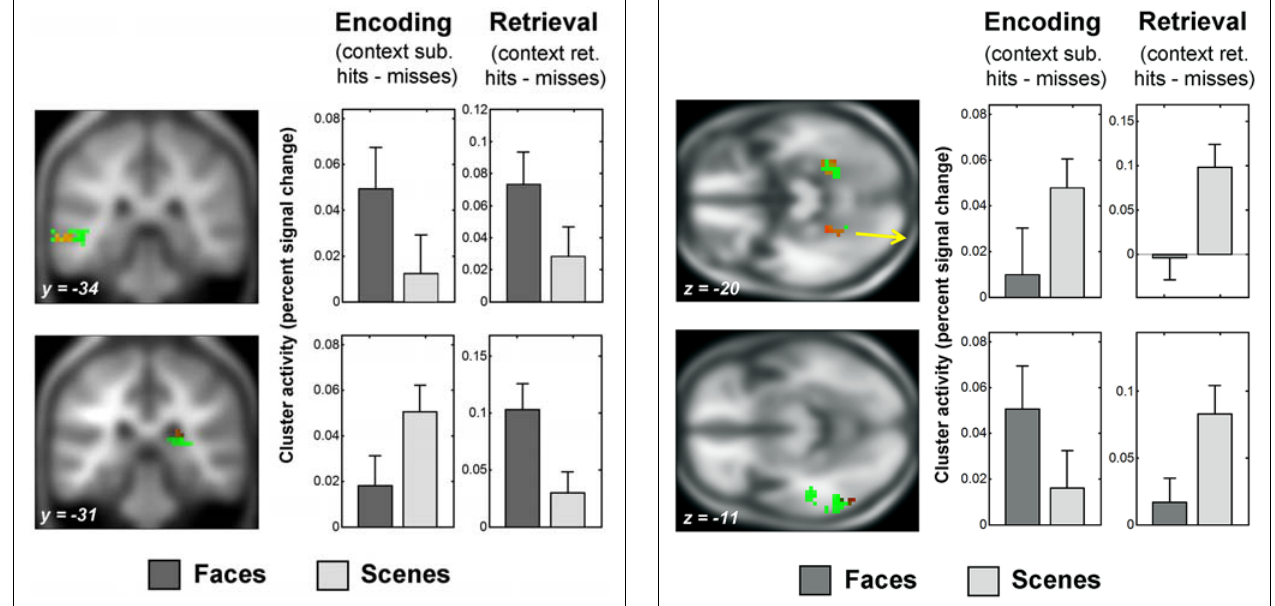
FIGURE 4 | Recapitulation of encoding activity during scene context retrieval. The sections show the overlap of selective context retrieval effects (overlap shown in red) with selective context encoding effects (shown in green), displayed on the average anatomicalT1 image from this sample.Thresholds for display are those used in the overlap analysis (see Behavioral Analysis). Above: posterior parahippocampal gyrus regions which showed scene-selective encoding activity and scene-selective retrieval activity (peak x = − 24, y = − 40, z = − 20; and x = 30, y = − 46, z = − 17). Below: left middle occipital/inferior temporal gyrus region which showed face-selective encoding activity and scene-selective retrieval activity (peak x = − 54, y = − 61, z = − 11). See Figure 2 for information about the parameter estimate plots, fMRI Analysis and Data Analysis Strategy for details of contrasts and fMRI Findings for details of